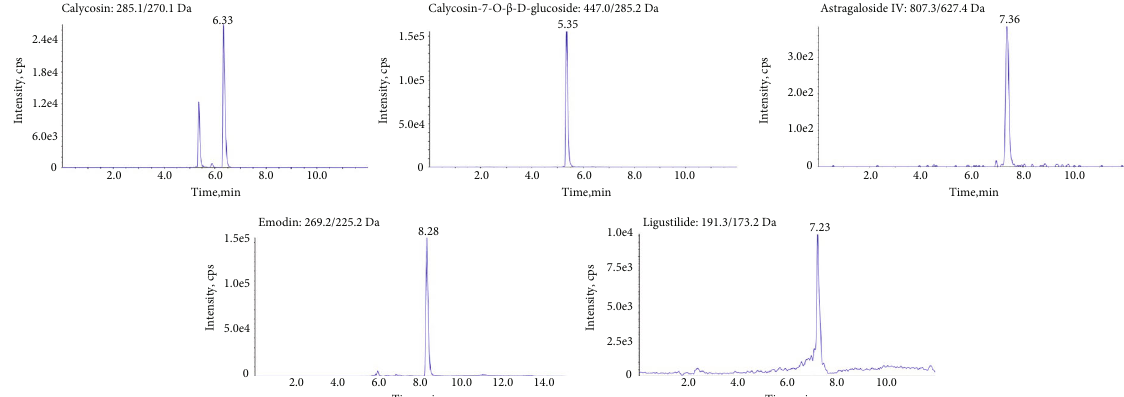
Figure 2: Typical UPLC-ESI-MS/MS chromatograms of fi ve bioactive components in